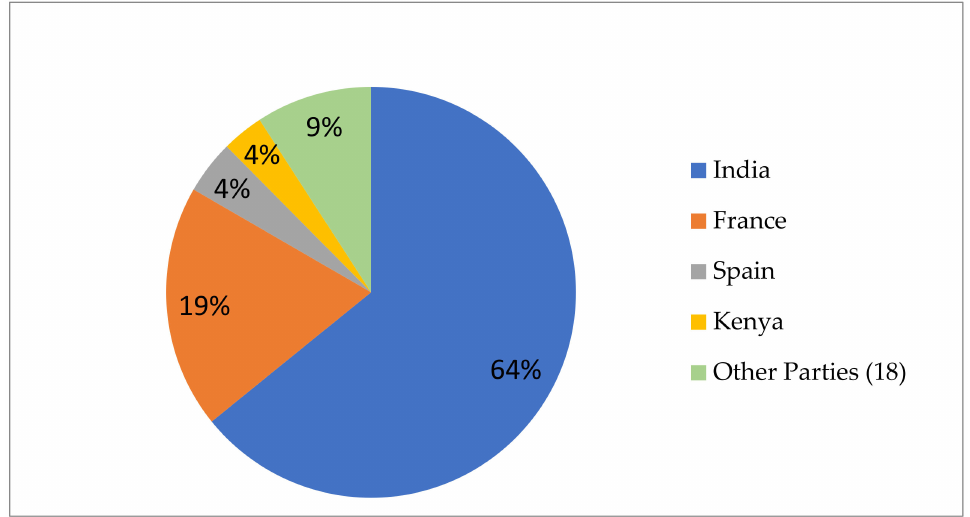
Figure 2. Distribution of IRCC available from the ABS CH as provided by Parties to the Nagoya Protocol, by 31 May